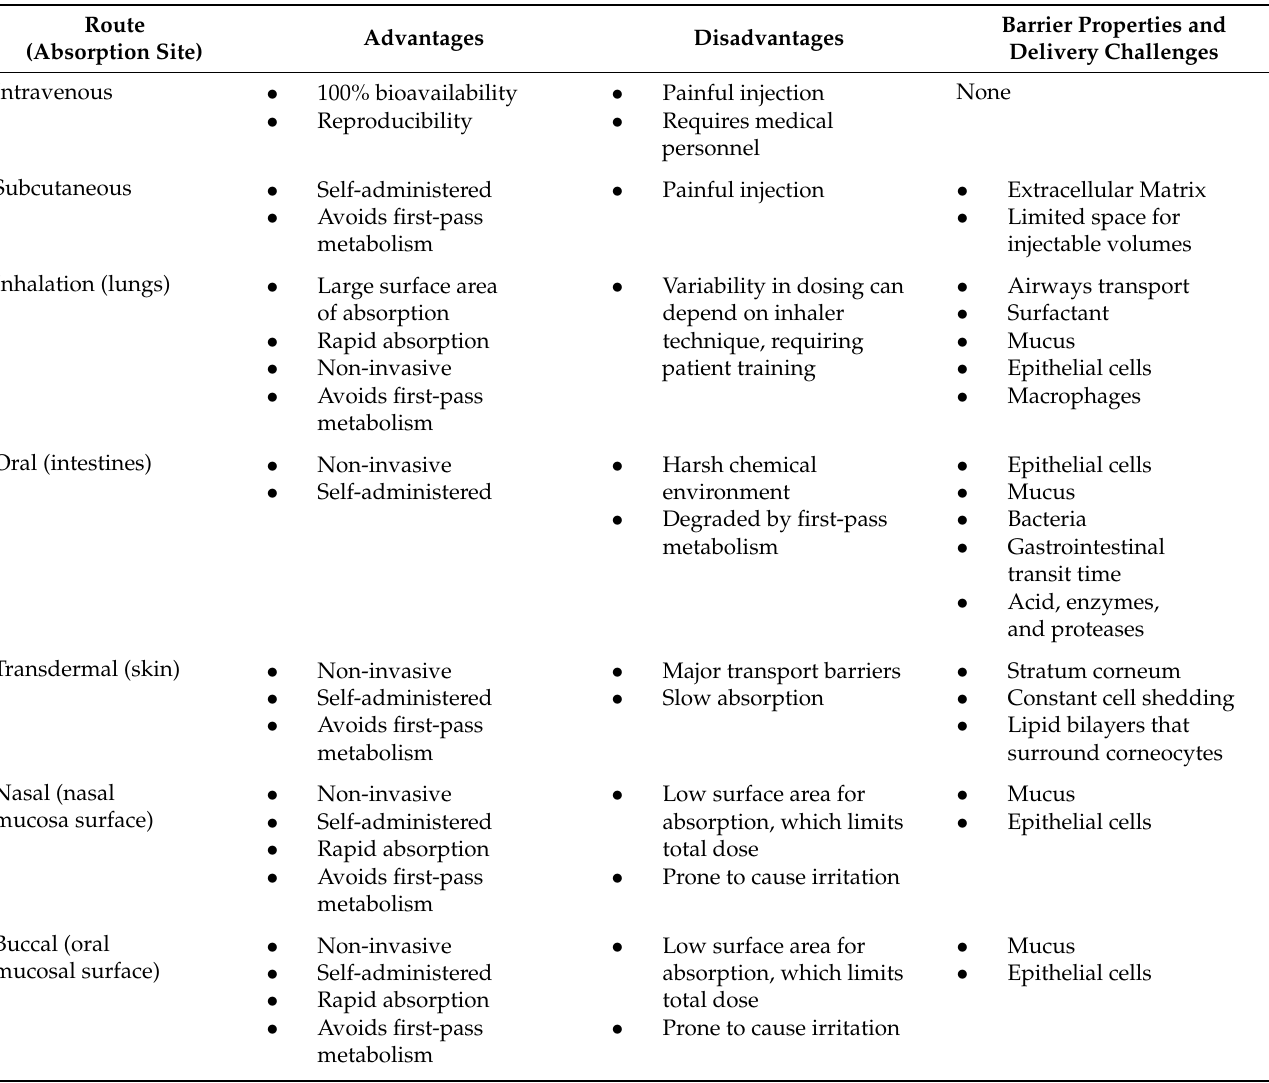
Table 1. Advantages and disadvantages of each route of